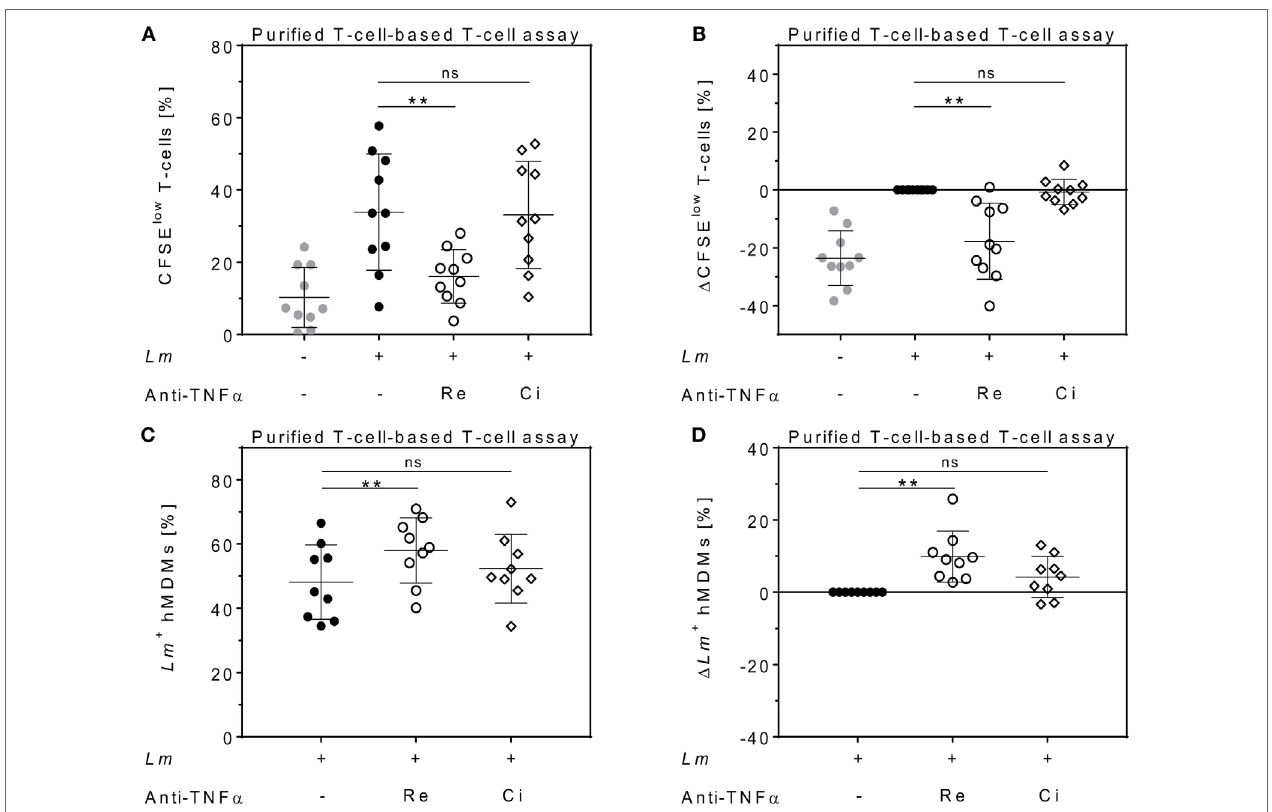
FigUre 4 | Effects of anti-tumor necrosis factor α (TNF α ) agents are human monocyte-derived macrophage (hMDM)- and T-cell-mediated. Magnetic activated cell sorting-separated CD14 + hMDMs were infected with Leishmania major ( Lm ) ( − Lm ● , + Lm ● ) and co-cultured with untouched CD3 + T-cells. The anti-TNF α agents Remicade ® (Re ○ ) and Cimzia ® (Ci ◊ ) were added and after 7 days, T-cell proliferation (a,B) and Lm infection rates in hMDMs (c,D) were analyzed by flow cytometry. (a,c) Raw data of T-cell proliferation and Lm infection rates are depicted without subtracting values from controls. (B,D) Values of the respective controls were subtracted for each donor and condition to illustrate differences. Results are presented as mean ± SD ( n ≥ 9) and at least four separate experiments were conducted. The Wilcoxon signed-rank test was performed to evaluate statistical significance. ns P > 0.05; ** P <